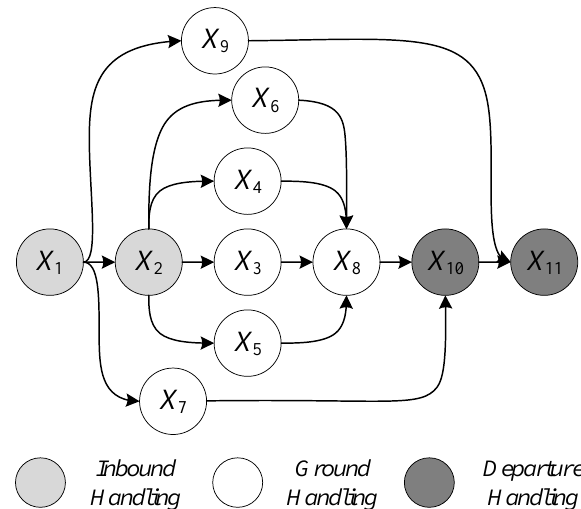
Figure 2. Idealized network topology graph of FGHP. X 1 : on block/docking bridge (stairs)/open